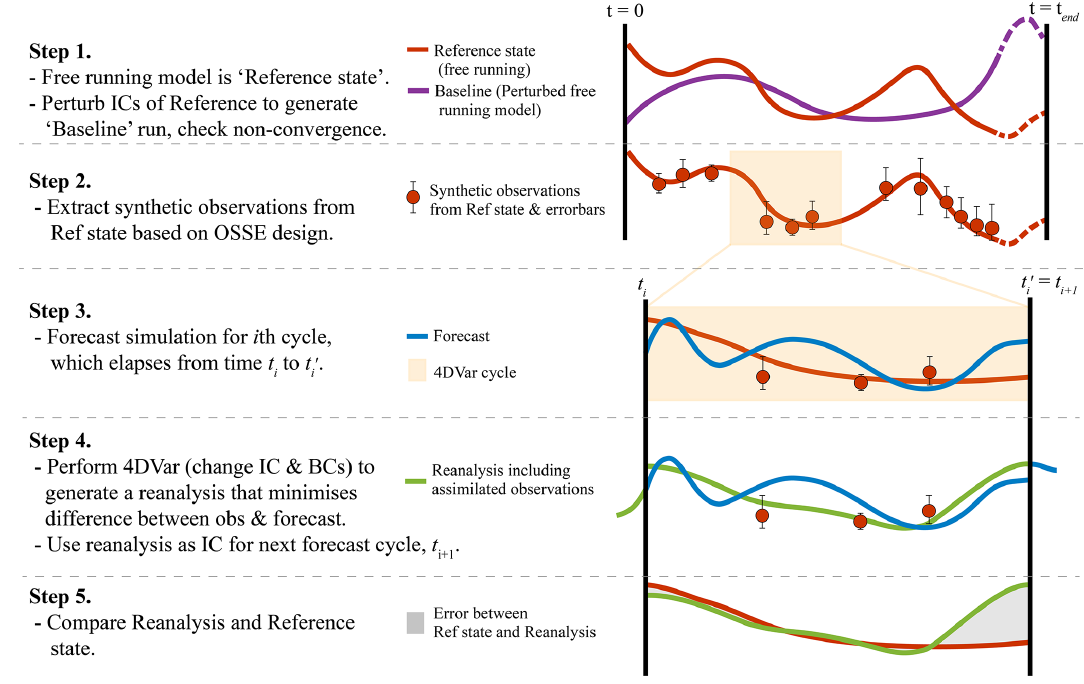
Figure 2. The steps taken for conducting and assessing an OSSE using 4DVar are shown schematically.